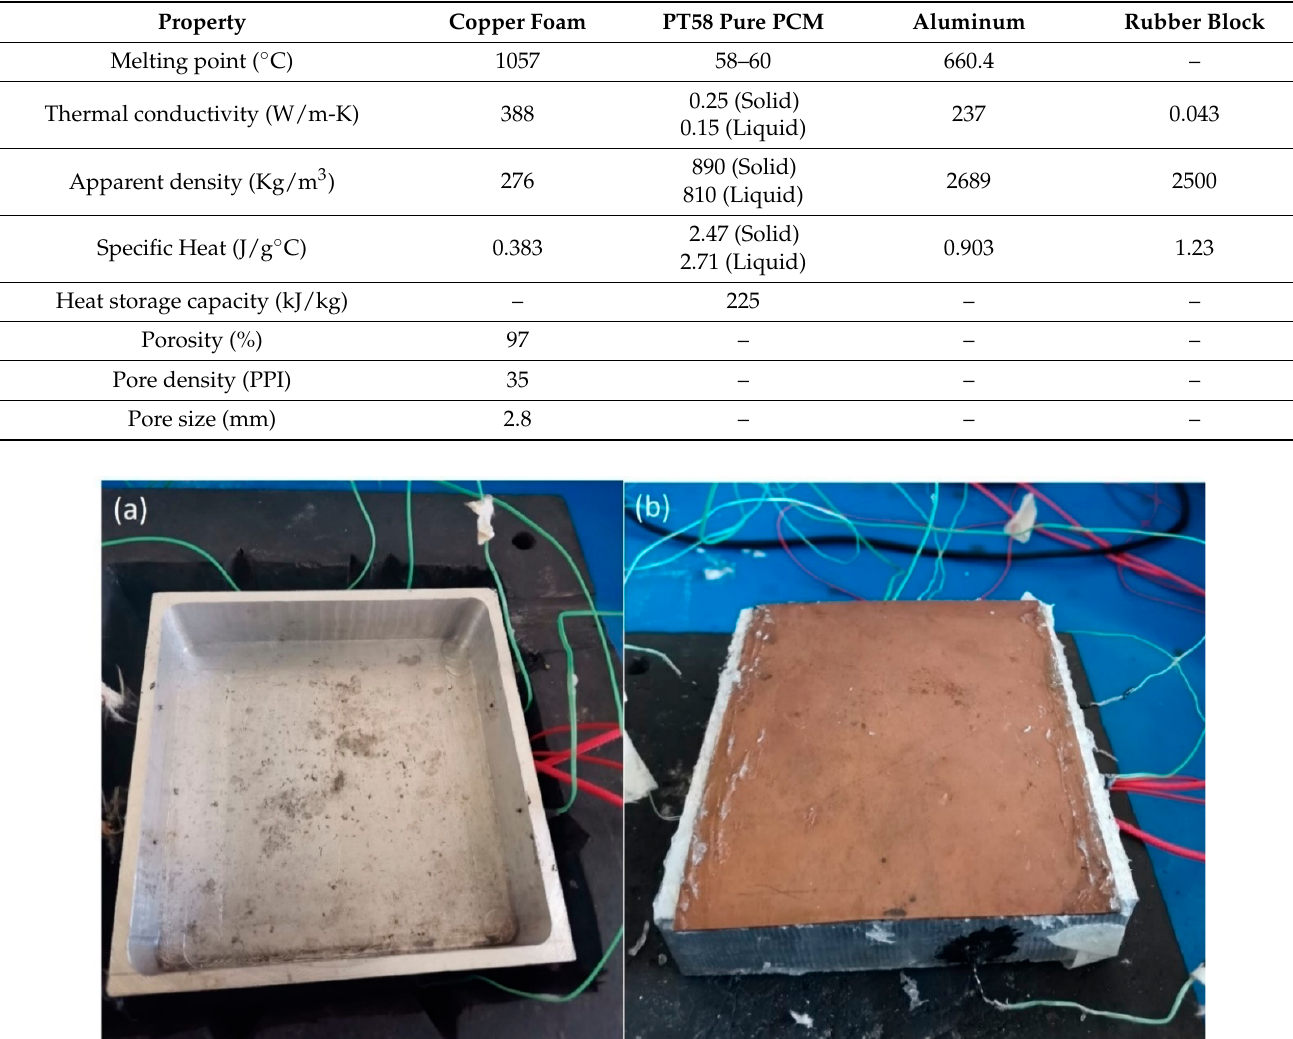
Figure 4 . Aluminum heat sink cavity: ( a ) Empty form; ( b ) Closed form. Figure 4. Aluminum heat sink cavity: ( a ) Empty form; ( b ) Closed form.